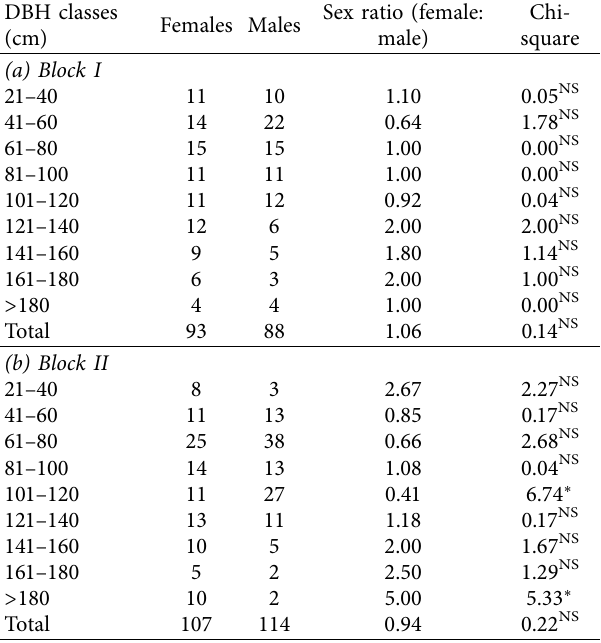
Table 3: The number of females, males, and sex ratio of P. falcatus individuals in diameter classes ( > 20 cm dbh) in the two blocks in Dodola